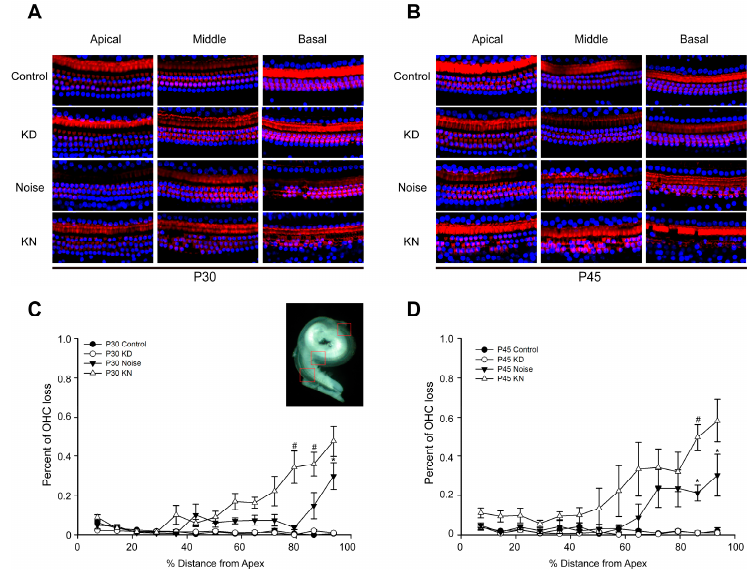
Figure 3. Hair cell loss patterns in control, KD, noise and KN groups. Patterns and time courses of OHC loss in control and experimental groups ( n = 3–4 in each group). Panels ( A , B ) show the examples of the HC nucleus ( blue ) and F -actin ( red ) in control, KD, noise and KN groups; Three rows of OHCs are at the bottom; Panels ( C , D ) show quantifications of OHC loss at specific cochlear locations in control and different experimental groups. The inset in panel C shows a dissected surface preparation and the red frames represent different check points.* Significantly different from the control group ( p < 0.05); # Significantly different from the noise group ( p < 0.05). Plot legends for different groups are given in the panels.